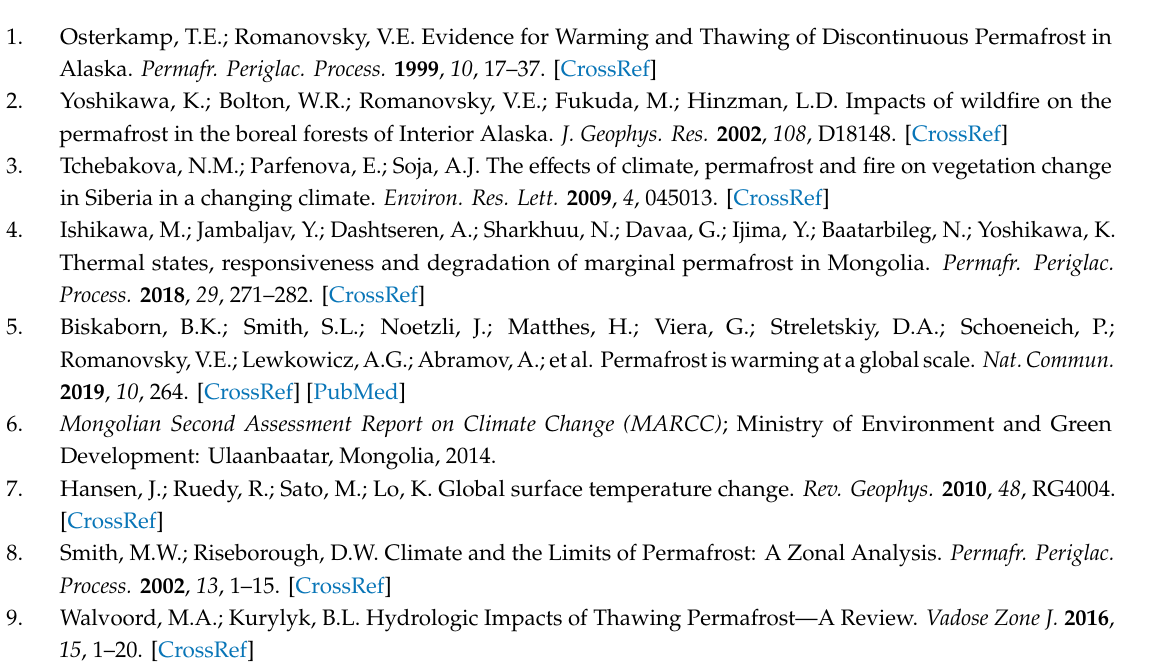
Figure S1: Observed annual air temperature and accumulated snow depth, Figure S2: Mean temperature di ff erence between burned and unburned forests, Figure S3: Observed liquid soil water content at unburned forest site, Table S1: Soil texture and water content, Table S2: Overview of snow field